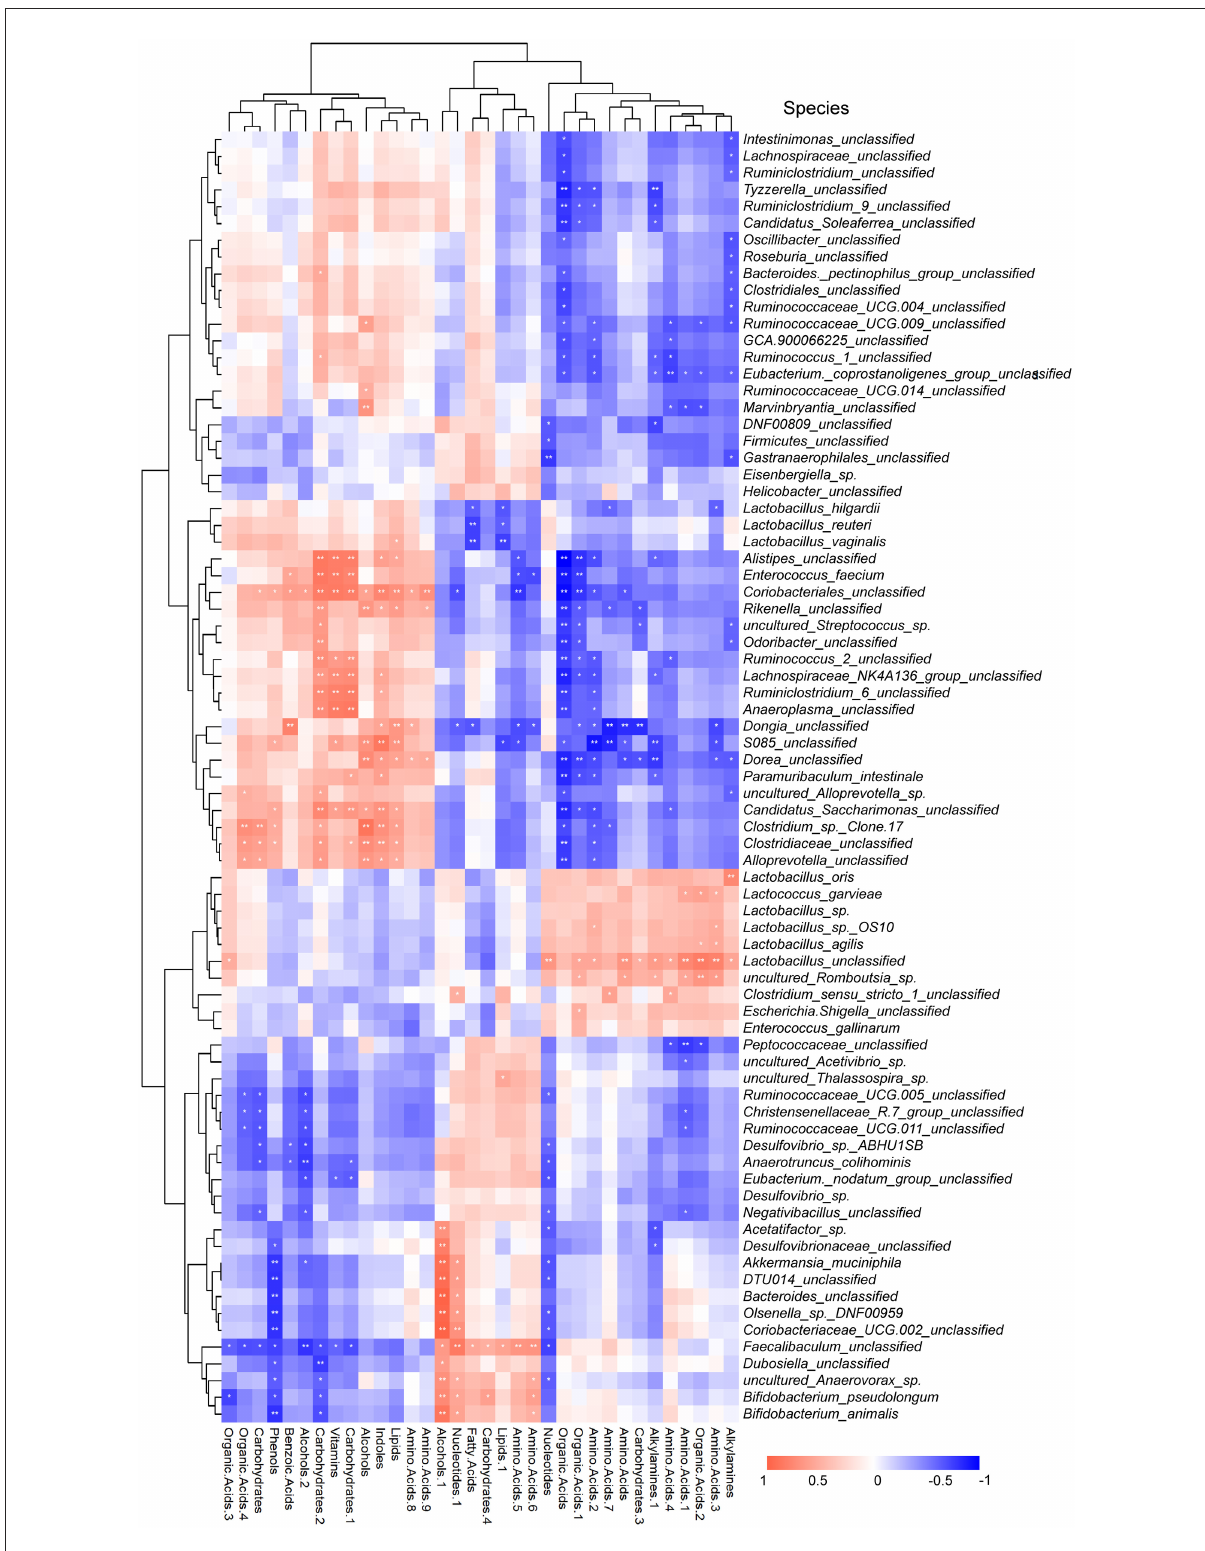
FIGURE8 Heatmap for correlation analysis of gut microbiota and serum metabolites. Red (blue) represents positive (negative) correlation, and the whiter the color, the weaker the correlation. The * p < 0.05 and ** p < 0.01 indicates that the correlation analysis is statistically